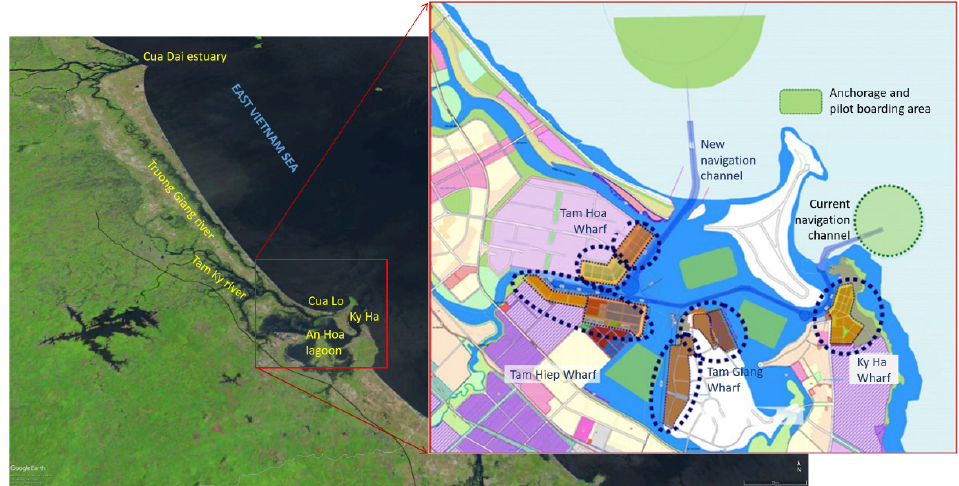
Figure 1. Location of the study area and Master plan for Chu Lai port .